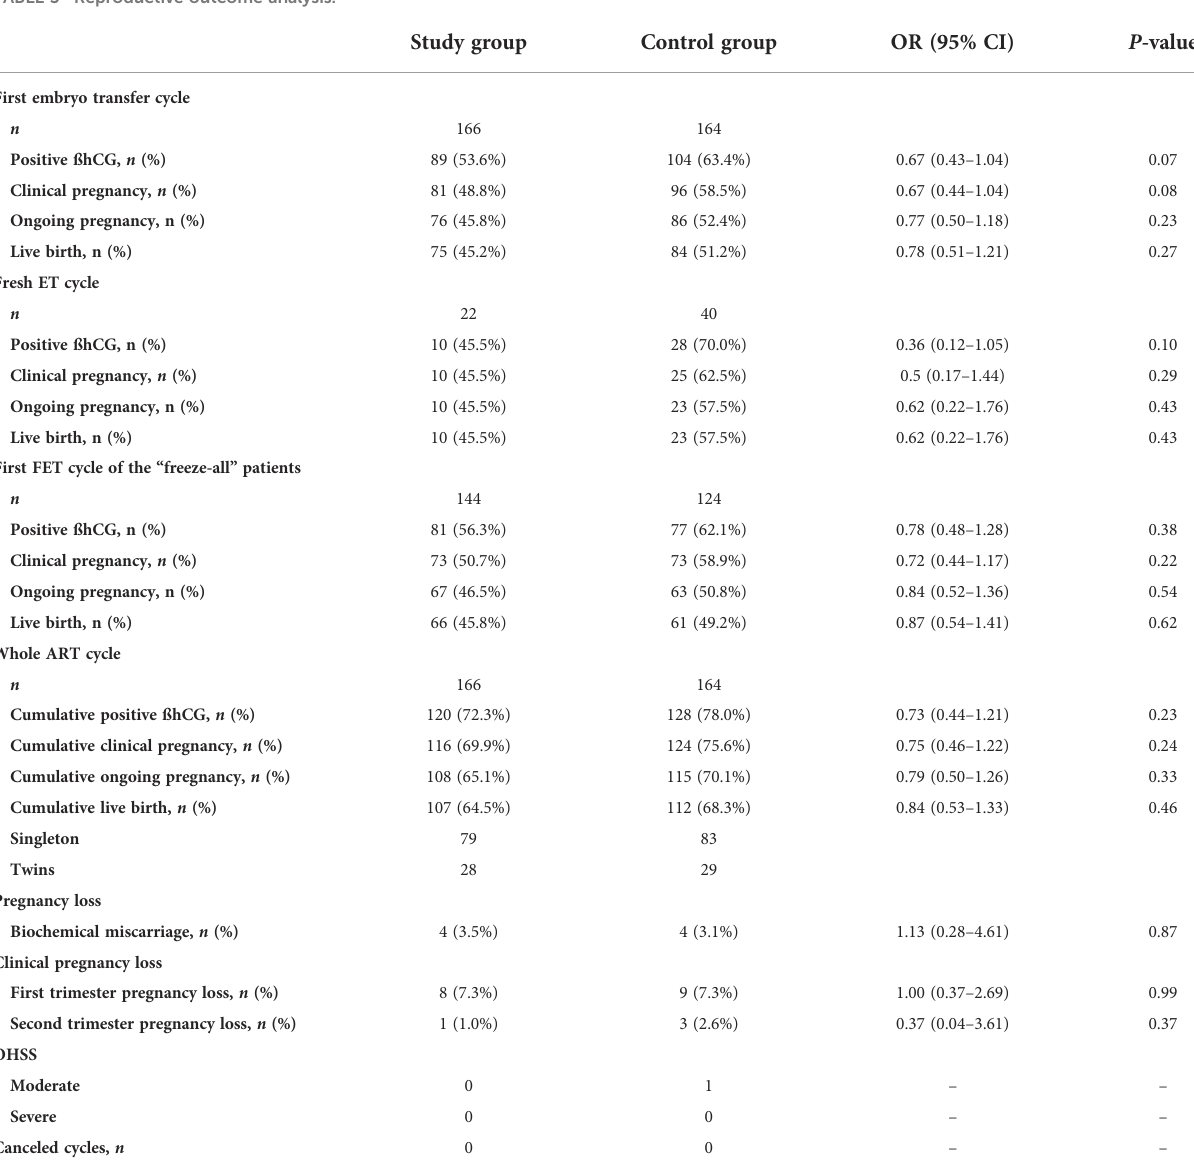
TABLE 3 Reproductive outcome analysis.